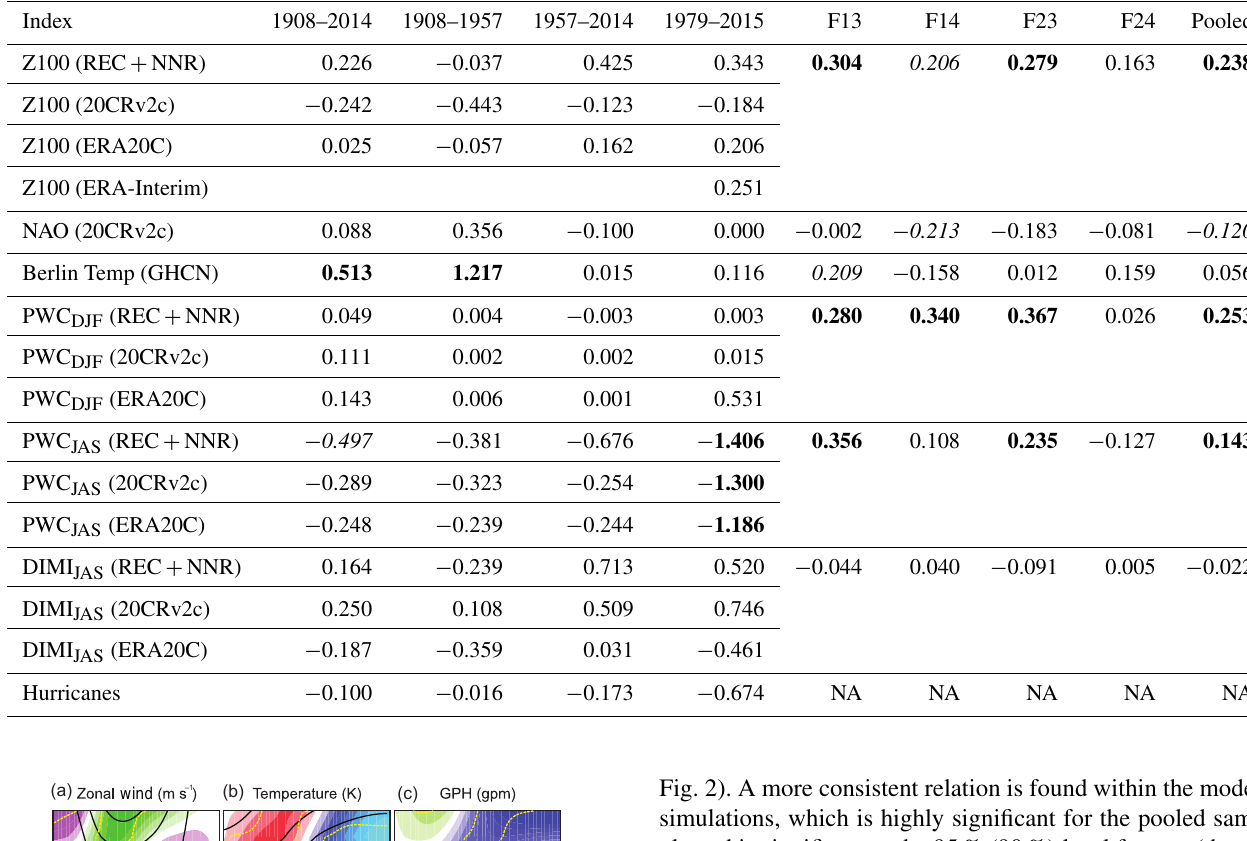
Table 1. Standardized difference in indices between easterly and westerly QBO phases in different observation-based data sets as well as in the climate model simulations (F13, F14, F23 and F24 denote the simulation numbers; also shown is the result for the pooled simulations). Bold and italics denote significance at the 95 and 90% levels, respectively. REC + NNR is the combination of reconstructed indices up to 1947 and NCEP/NCAR Reanalysis thereafter.